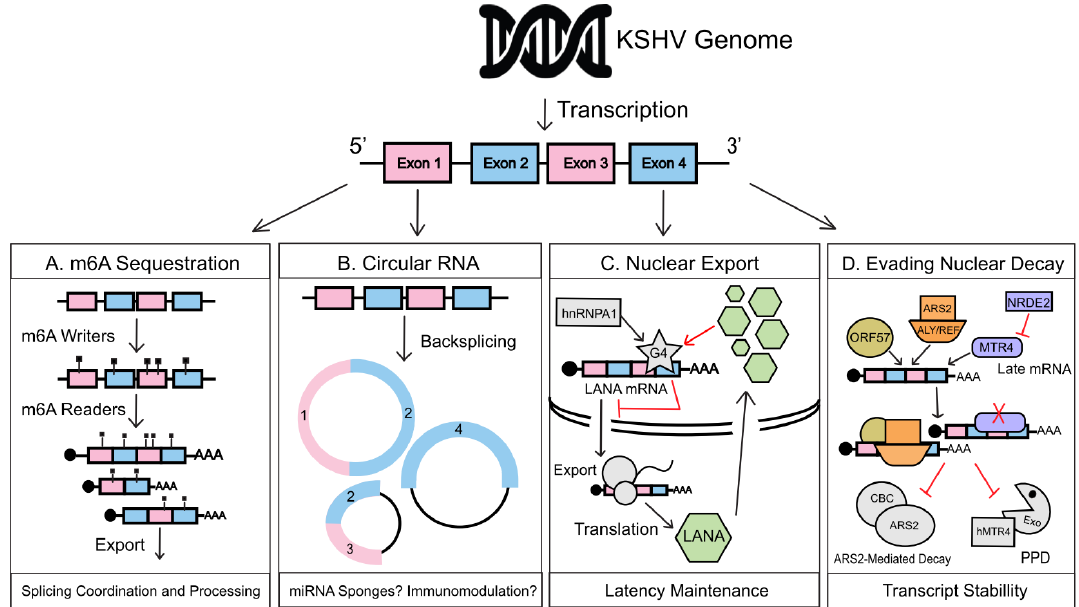
Figure 1. Kaposi’s sarcoma-associated herpesvirus (KSHV) manipulation of nuclear RNA regulation. ( A ) During lytic reactivation, KSHV transcripts are preferentially m 6 A modified over host RNAs, co-opting host m 6 a readers and writers to direct viral mRNA post-transcriptional regulation, splice patterns, and nuclear export. ( B ) Back-splicing of viral RNAs leads to the production of viral circular RNAs (circRNAs). Viral circRNAs could act as microRNA (miRNA) sponges to enhance translation of their linear counterparts and potentially encode novel viral peptides with as-yet to be defined functions. Several circRNAs are also packaged into KSHV virions, which points to a potential immunomodulatory role during primary infection. ( C ) G-quadruplexes are RNA secondary structures found within guanine rich regions of pre-mRNA formed by a unique hydrogen bond stacking interaction. A G4 structure within the LANA mRNA regulates hnRNPA1-facilitated transcript export. It also binds LANA protein in a negative feedback loop that finely tunes the amount of LANA transcripts within the cytoplasmic RNA pool. G4 regulation of LANA mRNA balances the amount of LANA being produced during KSHV latency, aiding in latency maintenance. ( D ) The lytic early gene, ORF57, binds to KSHV early and delayed early transcripts in complex with